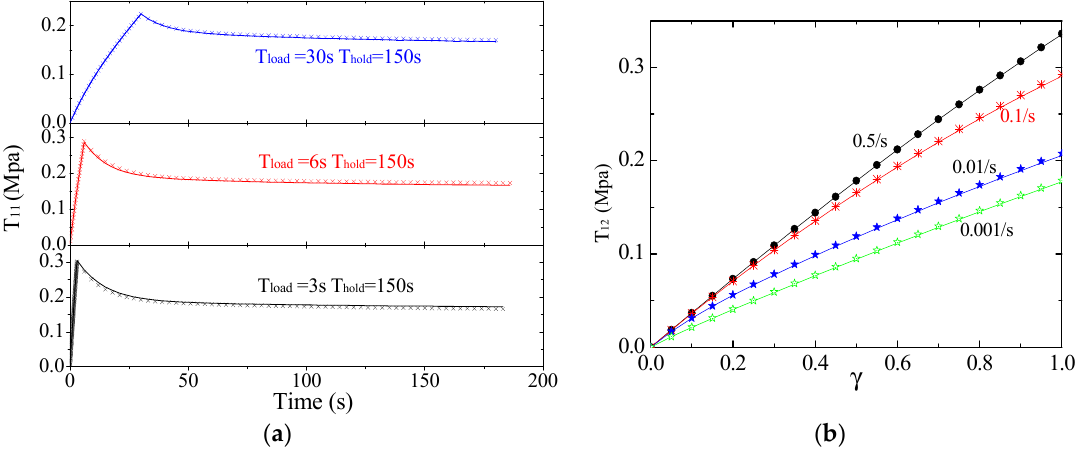
Figure 6. Verification of the identified parameters ( a ) relaxation tests ( b ) simple shear tests.